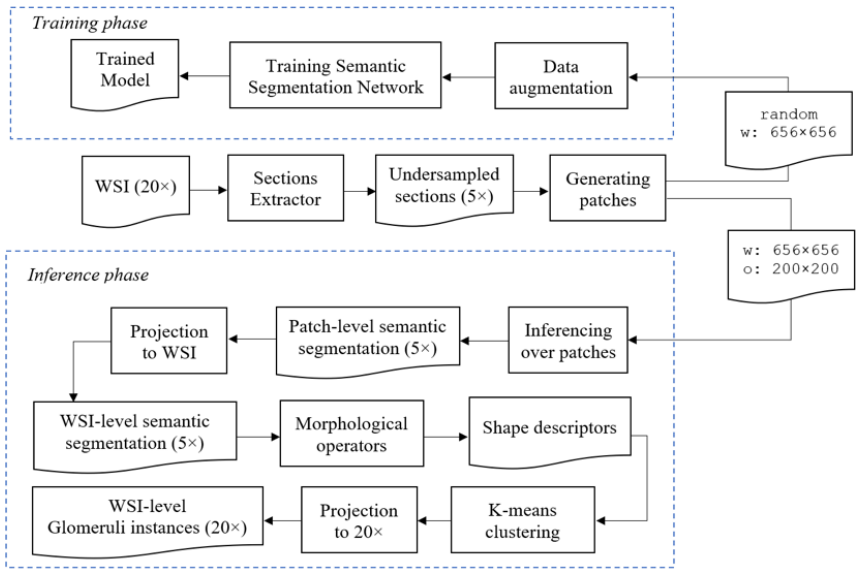
Figure 3. Semantic Segmentation approach architecture. The top part describes how to train the CNN. The bottom part explains how to use the trained model for performing inference, and the related morphological and clustering post-processing